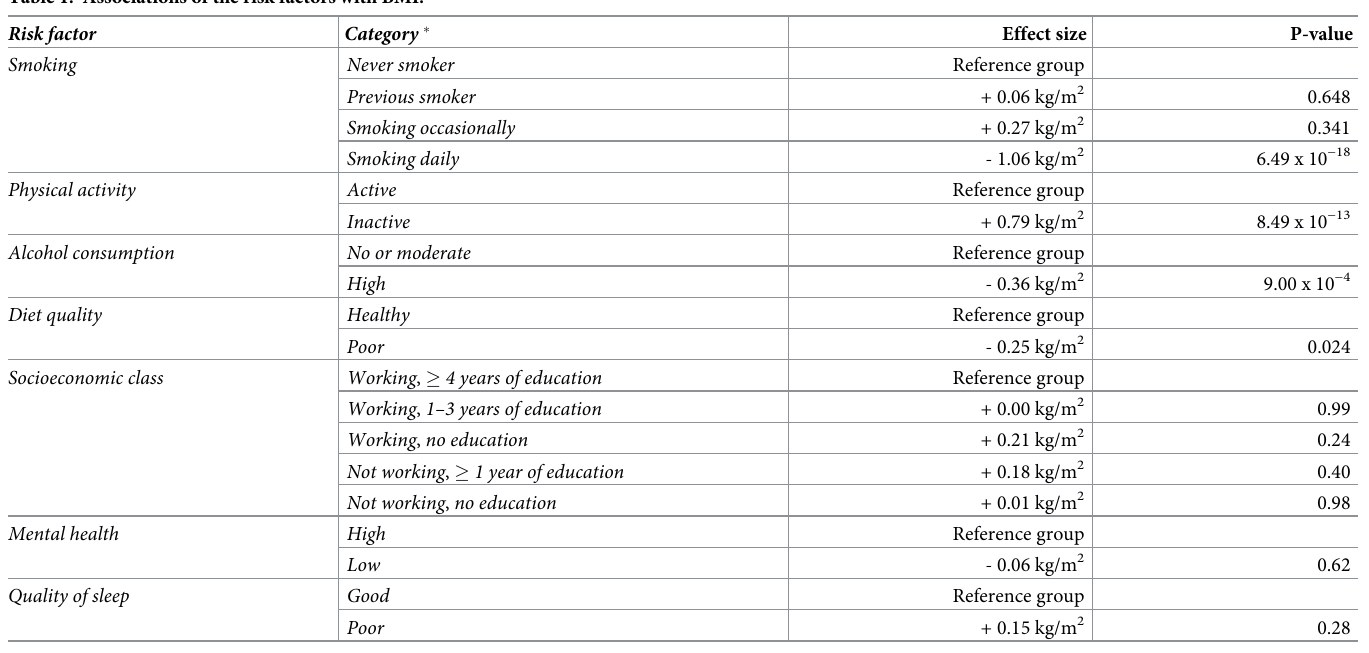
Table 1. Associations of the risk factors with